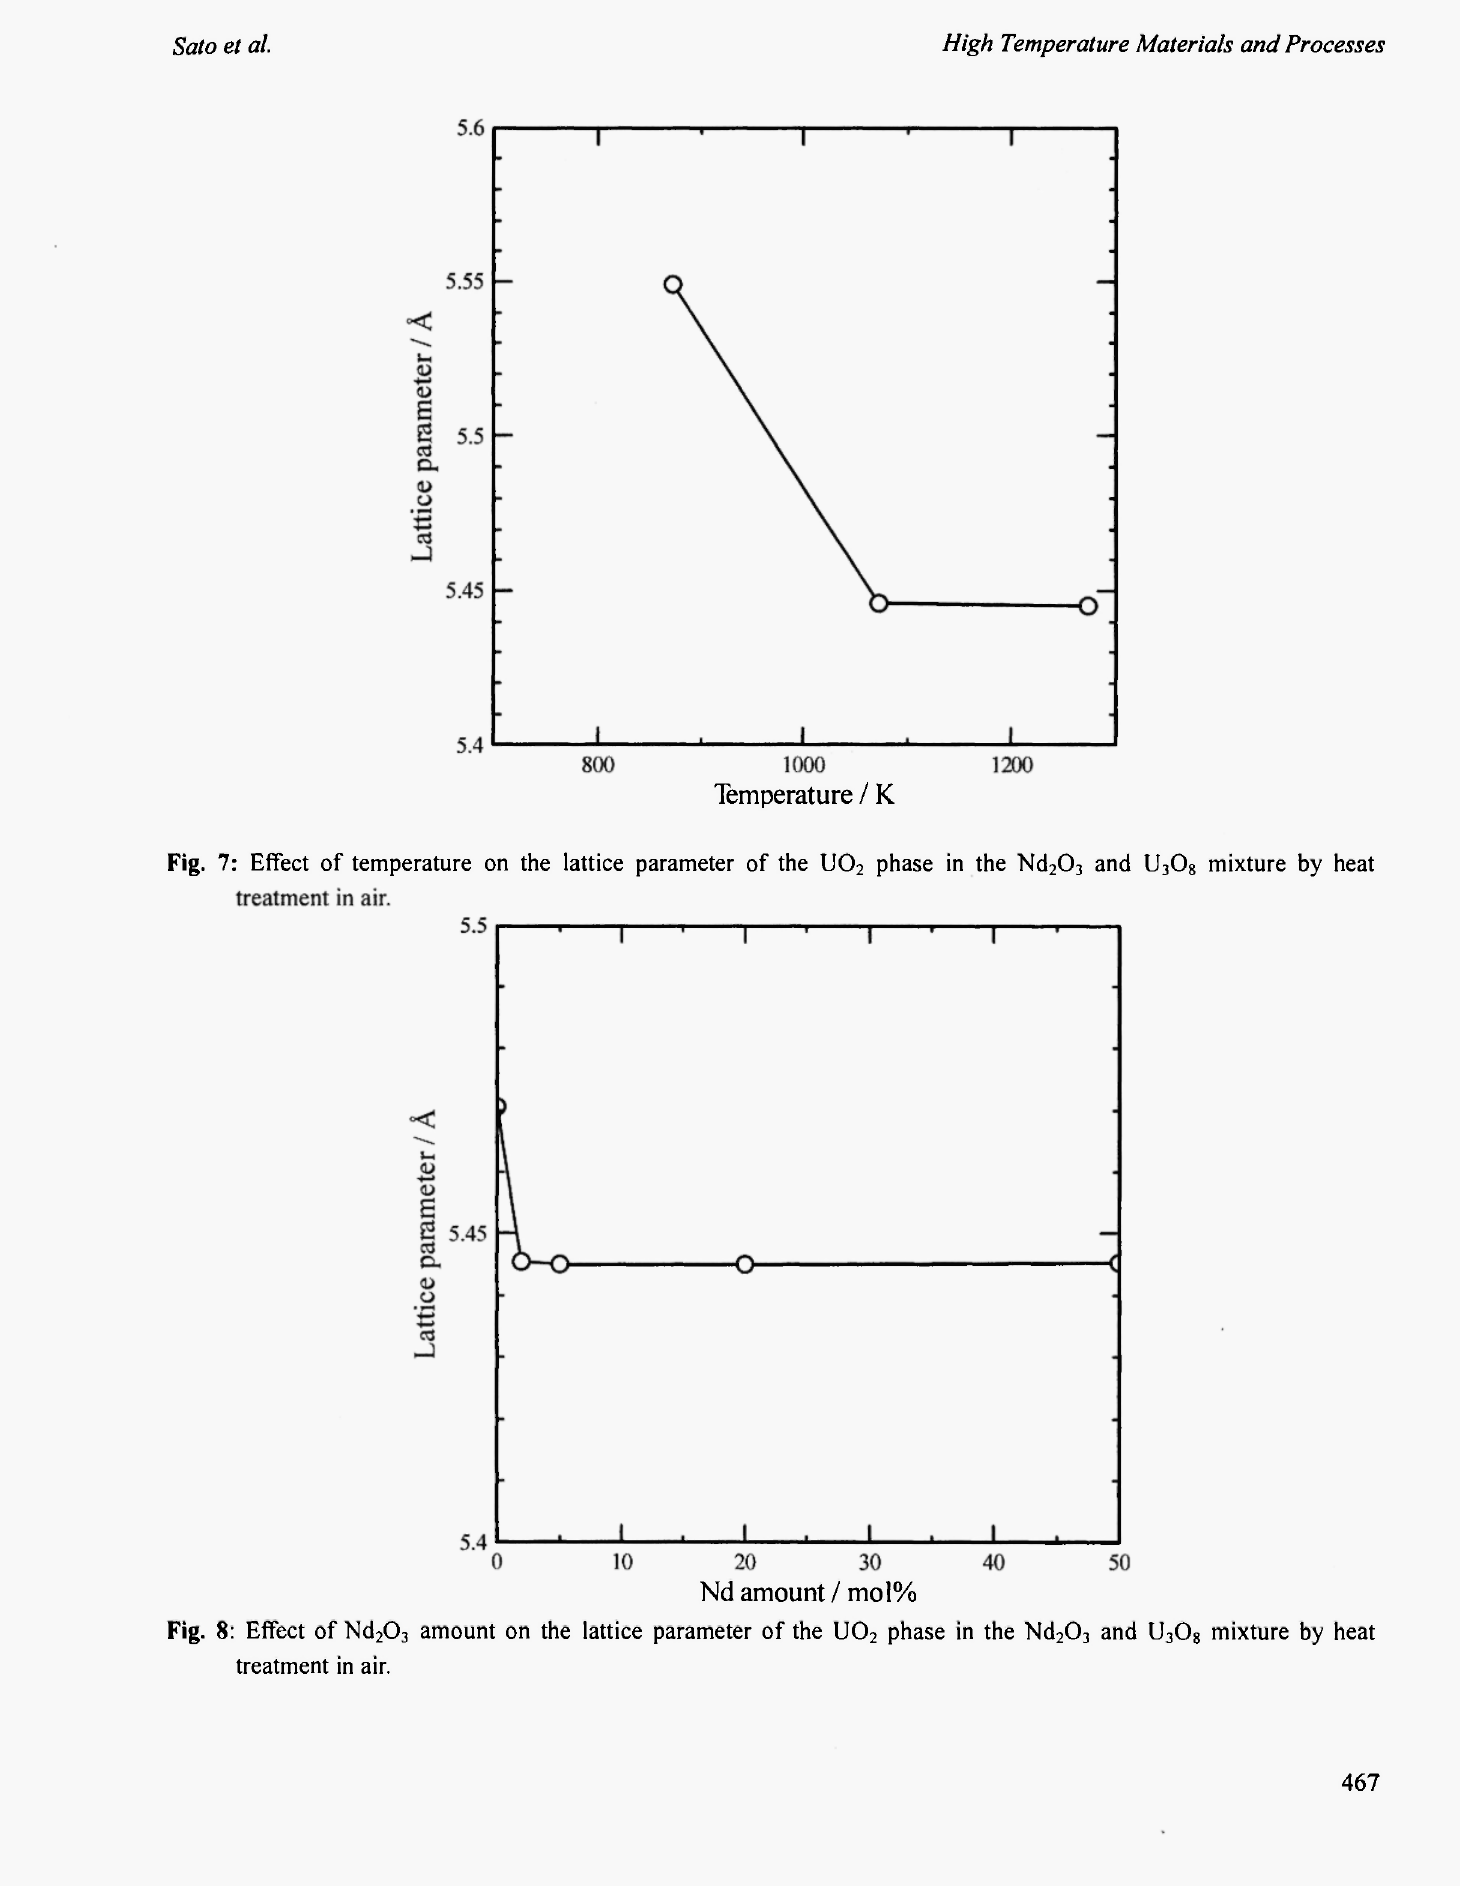
Fig. 8: Effect of Nd 2 0 3 amount on the lattice parameter of the U0 2 phase in the Nd 2 0 3 and U 3 0 8 mixture by heat treatment in